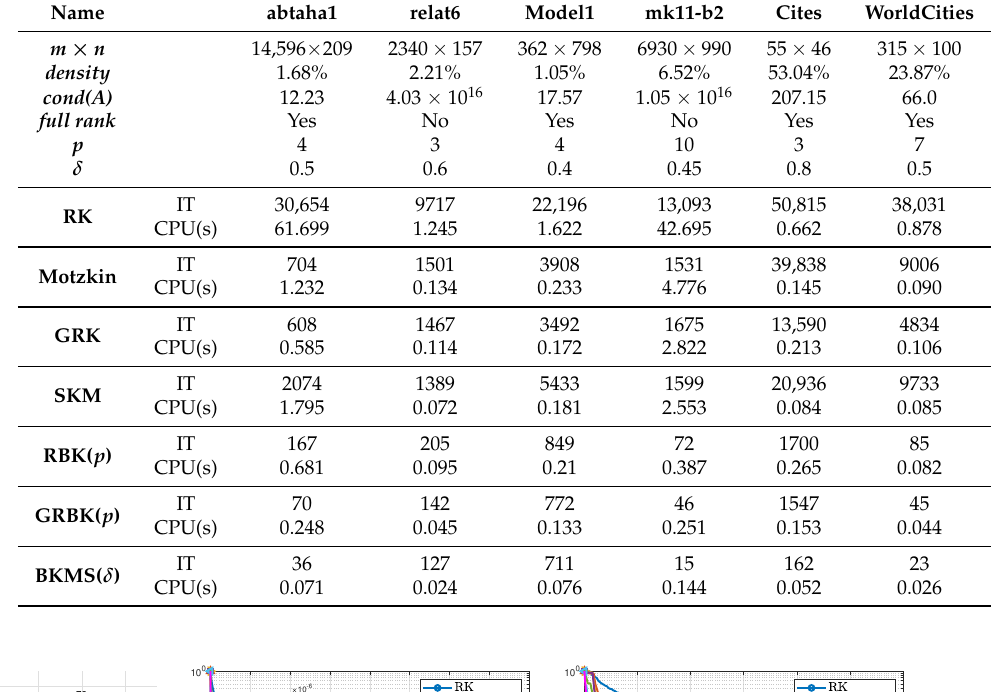
Table 2. IT and CPU of all methods for the sparse consistent linear system.